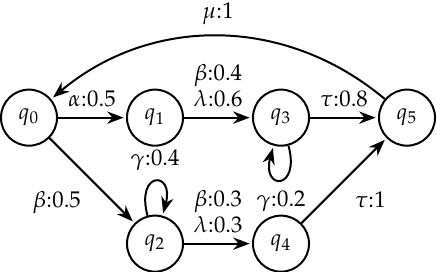
Figure 1. A probabilistic automaton structure G s